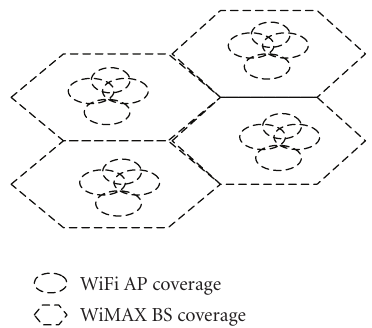
Figure 14: WiFi-WiMAX wireless coverage.